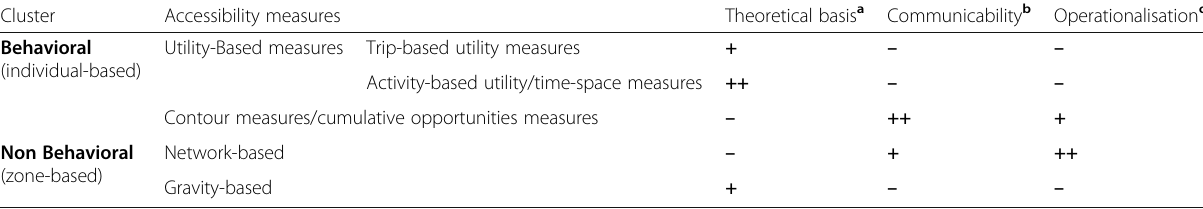
Table 2 Taxonomy of accessibility indicators Cluster Accessibility